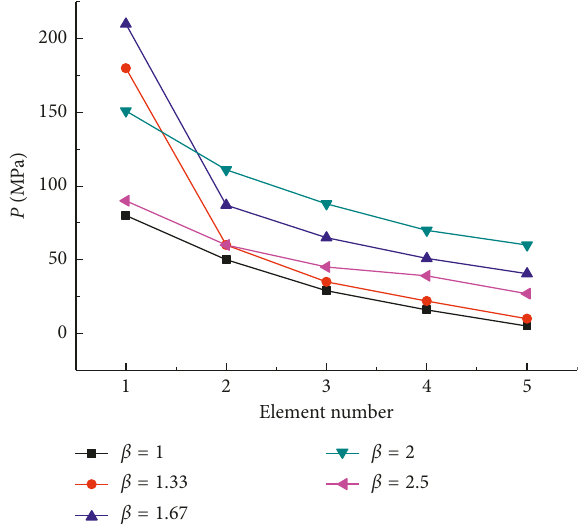
Figure 10: Stress-time curves of coal elements at different distances ( β is the radial decoupling